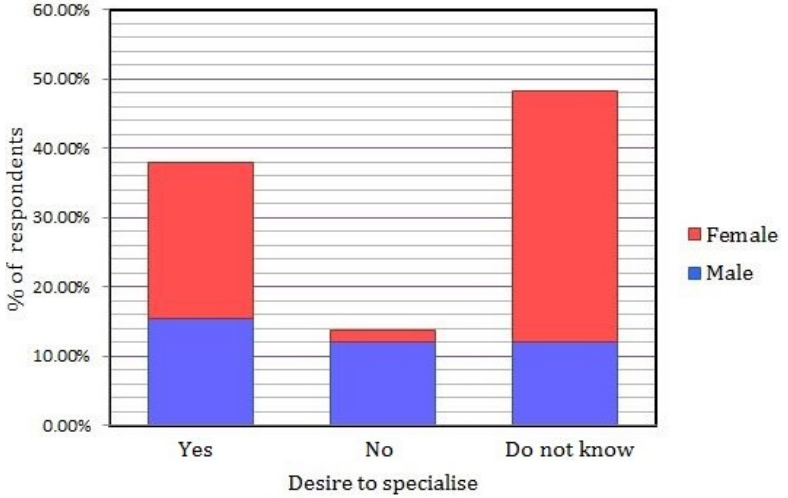
Figure 1. Percentage of respondents by gender and desire to pursue a specialist career.